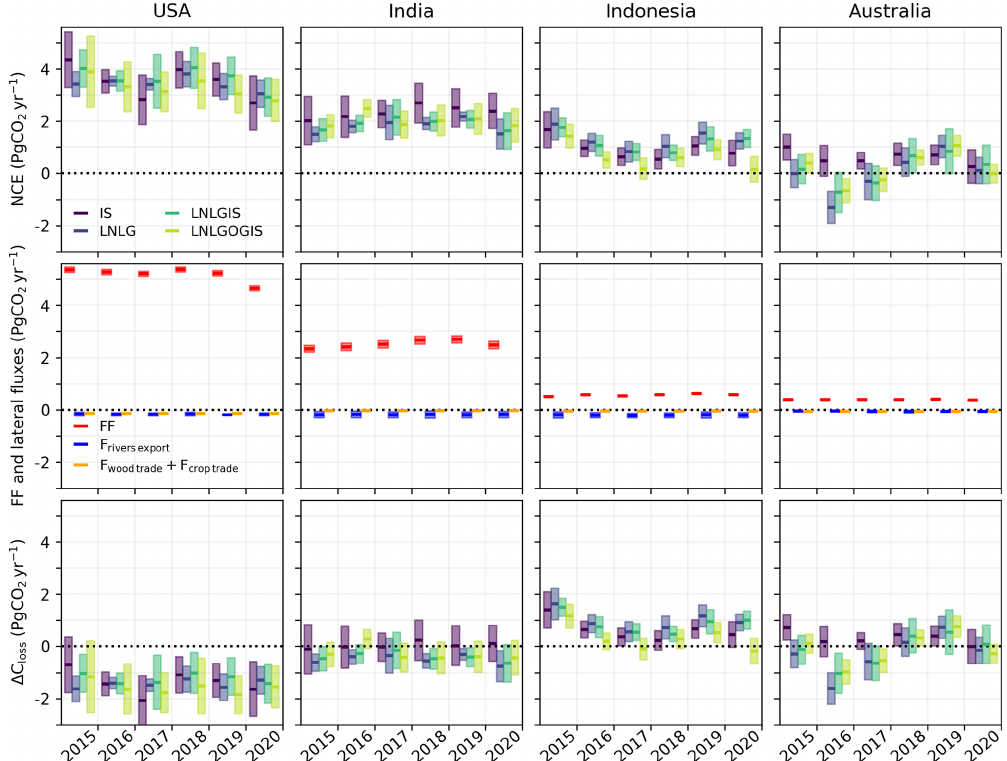
Figure 14. Time series of the carbon budget for the USA, India, Indonesia and Australia. Solid lines show the median estimates, and shaded areas show ± 1 standard